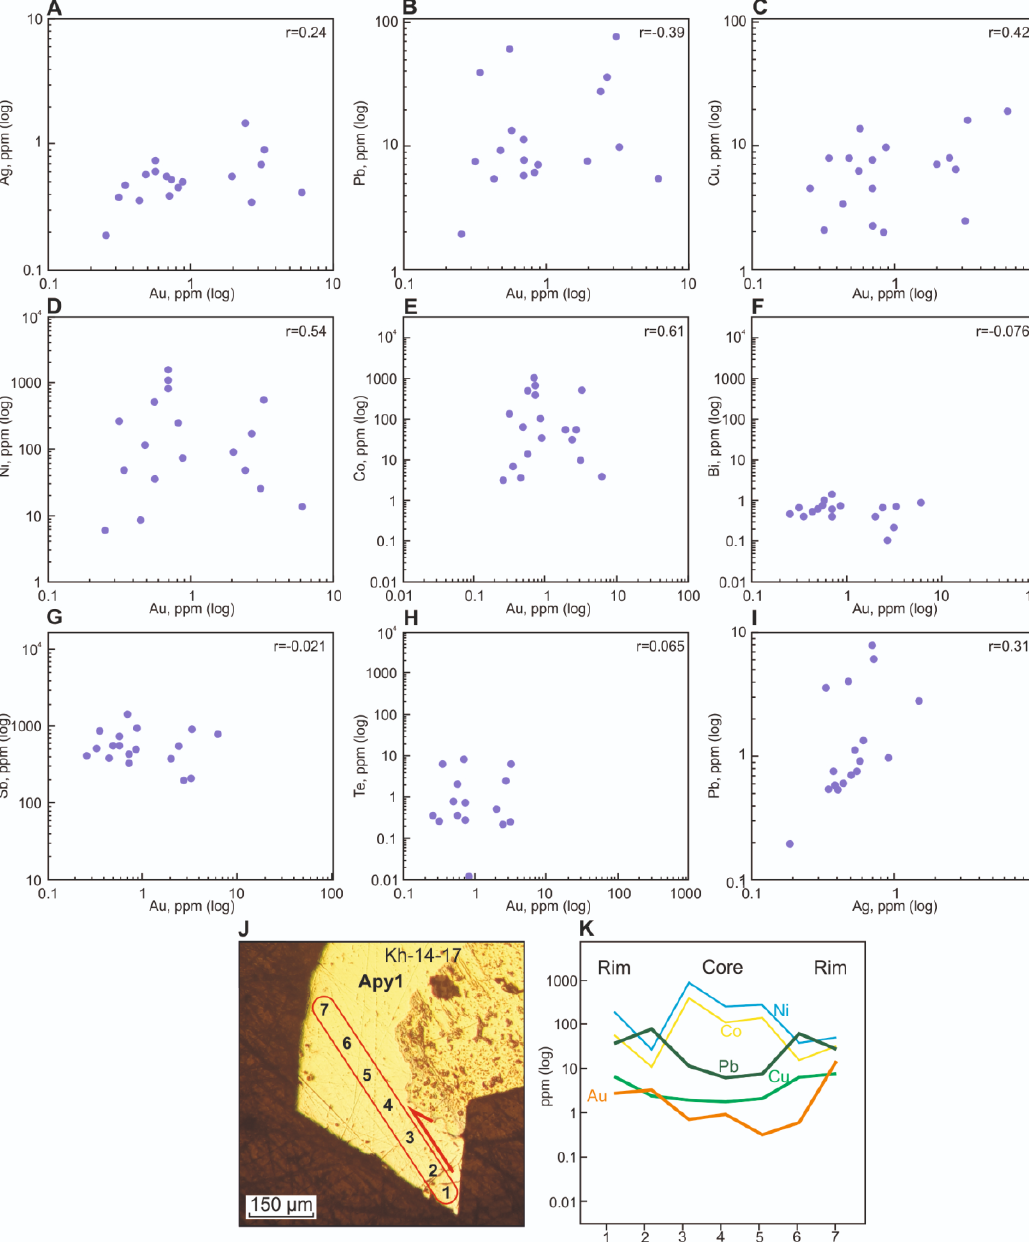
Figure 14. Correlation diagrams for Apy1: ( A ) Au vs. Ag; ( B ) Au vs. Pb; ( C ) Au vs. Cu; ( D ) Au vs. Ni; ( E ) Au vs. Co; ( F ) Au vs. Bi; ( G ) Au vs. Sb; ( H ) Au vs. Te; ( I ) Ag vs. Pb. Distribution of some elements ( K ) inside Apy1 grain (sample K-14-17) ( J